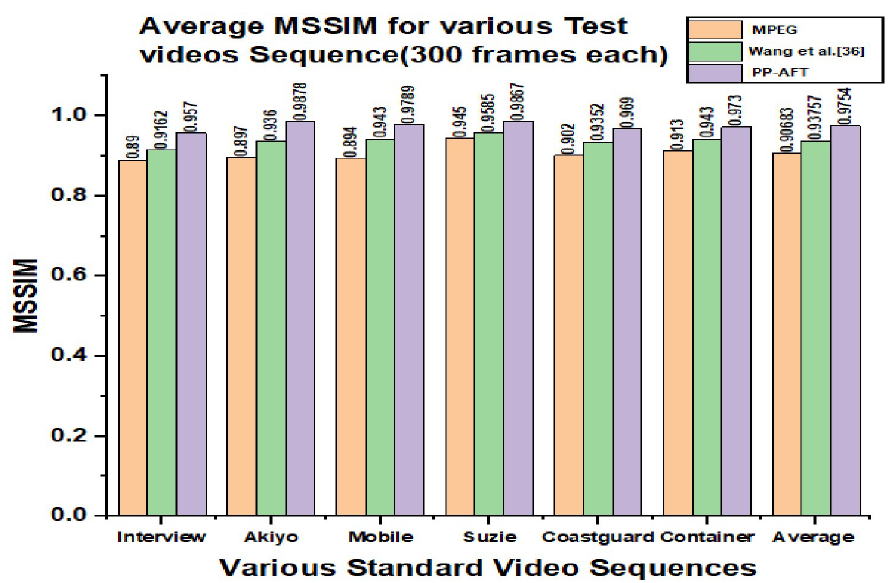
Fig 10. Average value of MSSIM for various video sequences.